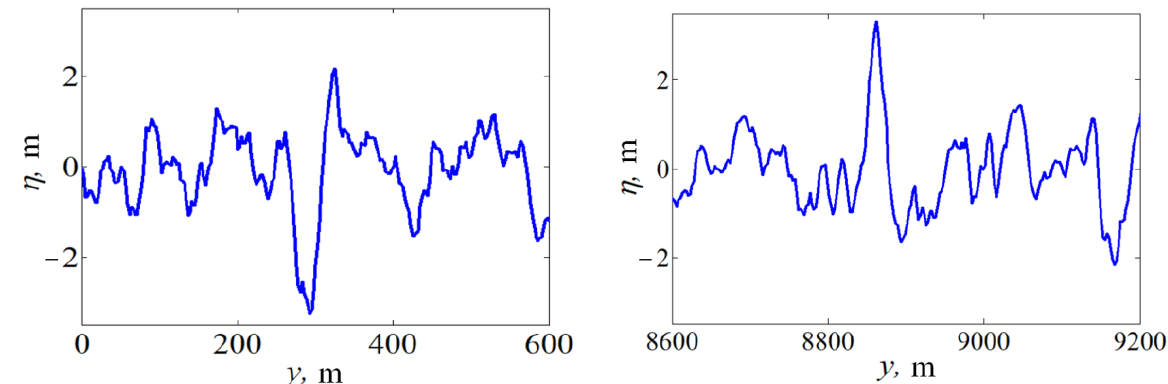
Figure 6. Profiles of freak waves occurred in random wind wave field.